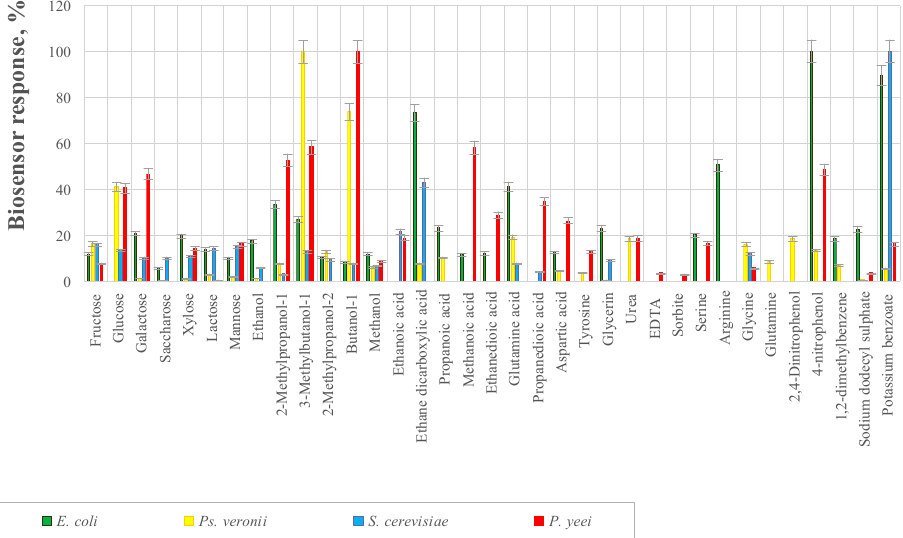
Figure 1. Substrate specificity of bioreceptor elements based on bacteria E. coli K-802, Ps . veronii DSM 11331T, P. yeei VKM B-3302, and yeast S. cerevisiae VKM Y-1173.